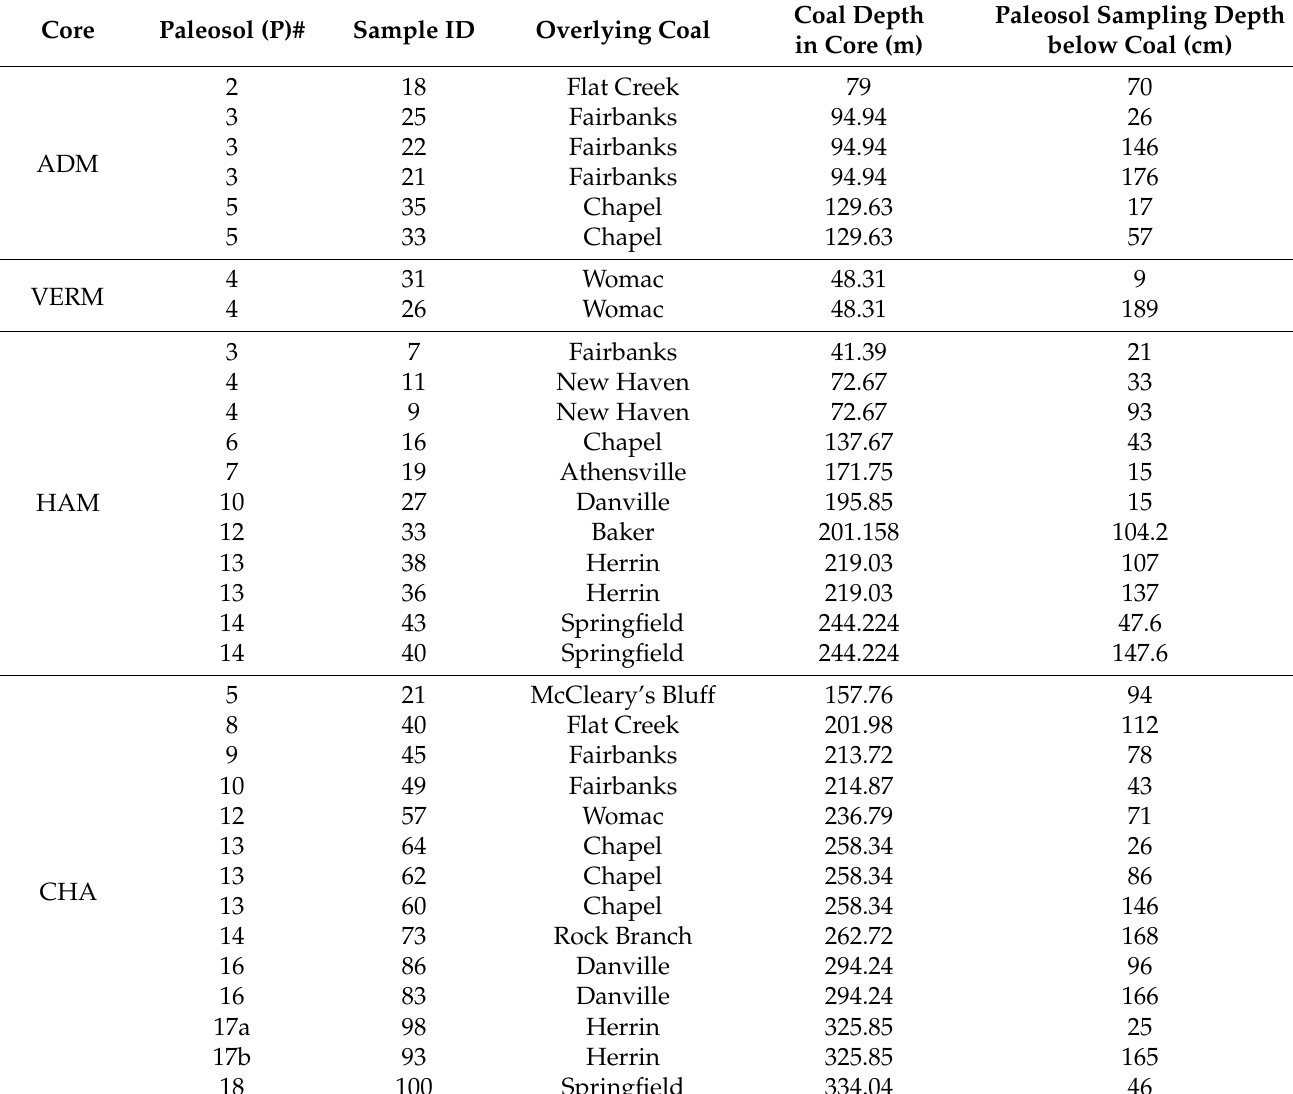
Table 4. Paleosols samples and their overlying coal